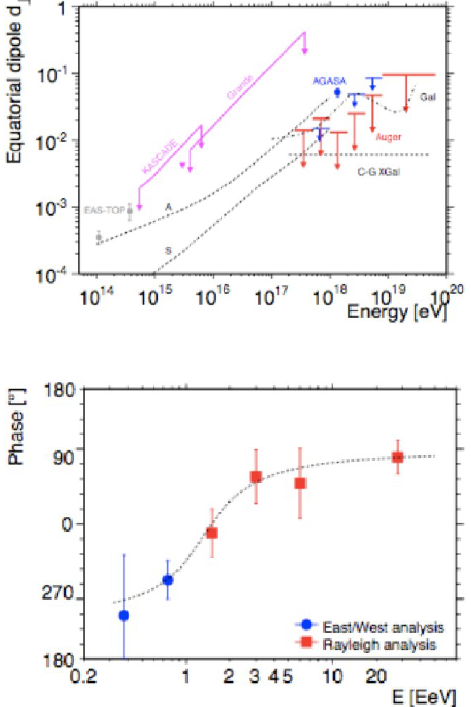
Figure 7: Equatorial dipole component (top) and phase of the first harmonic (bottom) as a function of energy.